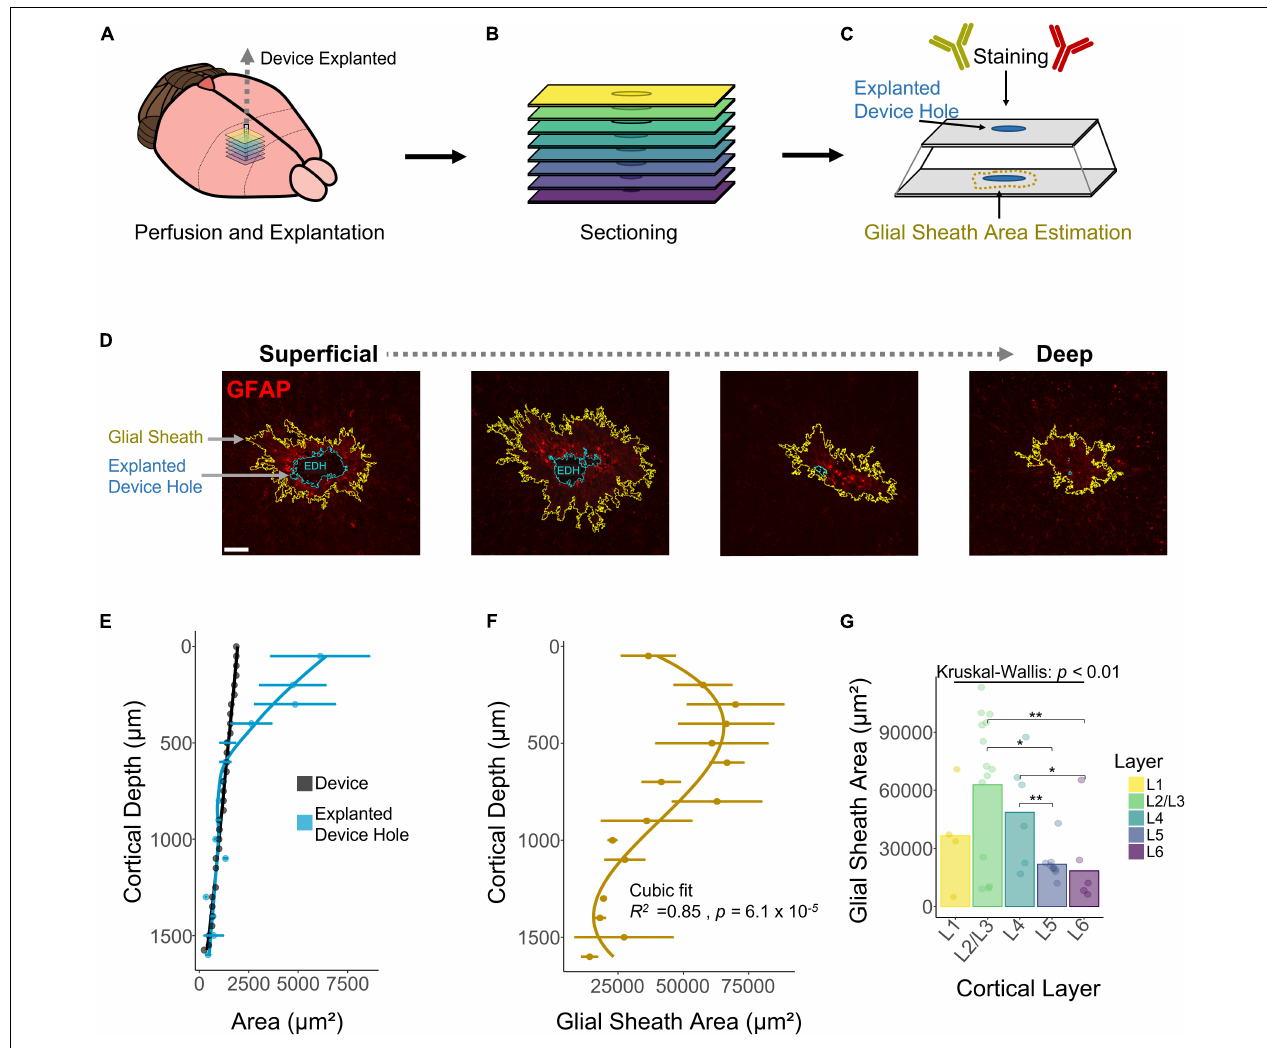
FIGURE 6 | Histological assessment and quantification of the astrocytic glial scar across cortical depth. Histological analysis across cortical depth was performed using DeepHisto. (A) After perfusion, the device was carefully extracted. (B) Horizontal tissue slices surrounding the device were systematically sectioned to keep track of cortical depth. (C) Samples were stained with GFAP and the area of the glial scar was measured. (D) Representative histological sections across cortical depth for one subject. Yellow outlines represent the astrocytic glial scar surrounding the electrode and the blue outlines represent the explanted device hole. (E) Quantification of the area of the explanted device hole in comparison with the cross-sectional area of the device. Lines represent a locally fitted polynomial regression of the mean. (F) Area of the astrocytic glial scar as a function of cortical depth. Line represents a cubic fit. (G) Laminar quantification of the area of the astrocytic glial scar. Analysis of variance and pairwise comparisons between layers were performed with a Kruskal–Wallis test and a Wilcoxon rank-sum test with Holm adjustment, respectively. Error bars in (E,F) indicate mean ± SEM. * p ≤ 0.05, ** p ≤